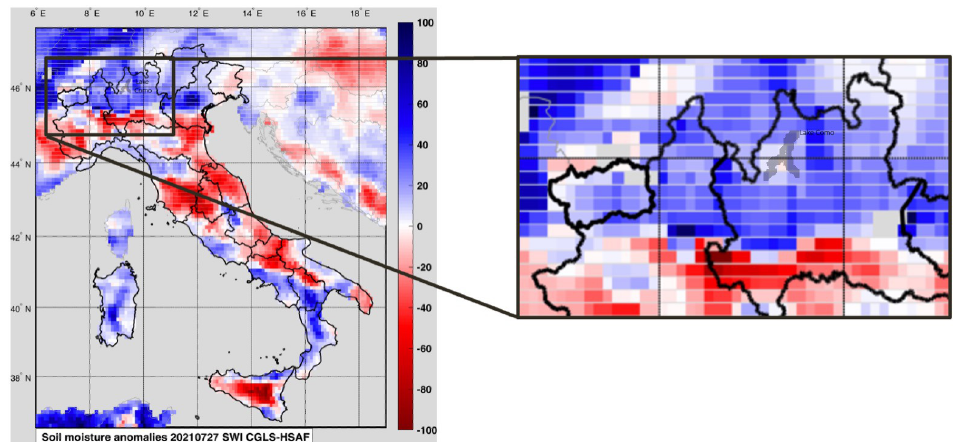
Figure 7. Zoom of soil moisture anomaly map (ASCAT Soil Water Index from Copernicus and EUMETSAT) for 27 July